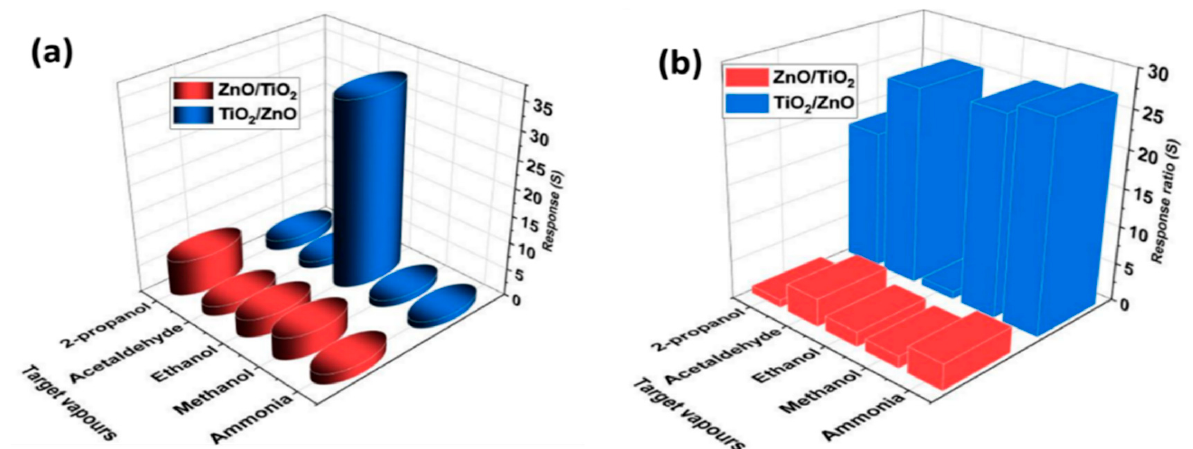
Figure 5. Selectivity ( a ) and selectivity factor ( b ) of samples ZnO/TiO 2 and TiO 2 /ZnO towards 100 ppm of various analytes.